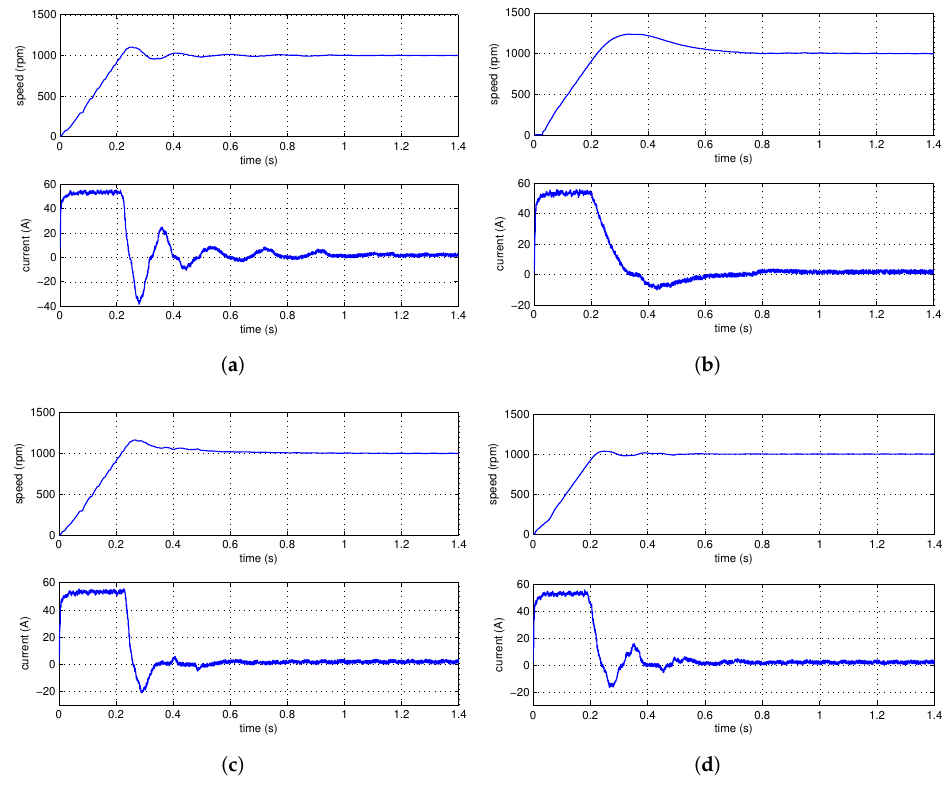
Figure 9. Step response comparisons. ( a ) FOPID. ( b ) IMC-PID. ( c ) CRONE. ( d ) FOPD-ESO.